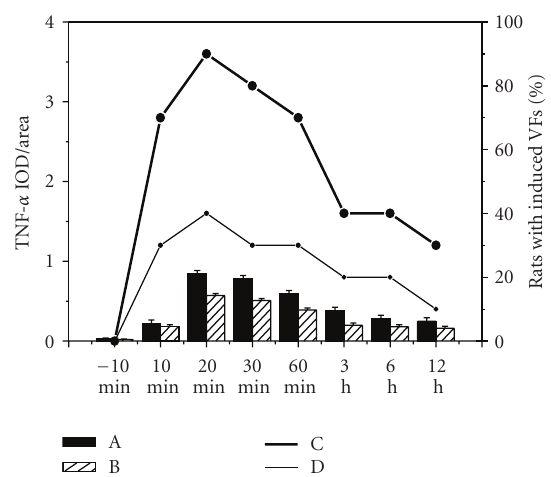
Figure 4: The relationship between TNF- α expression and induced VFs. A: Expression of TNF- α in AMI group; B: expression of TNF- α in rhTNFR:Fc group; C: percentages of rats with induced VFs in AMI group; D: percentages of rats with induced VFs in rhTNFR:Fc